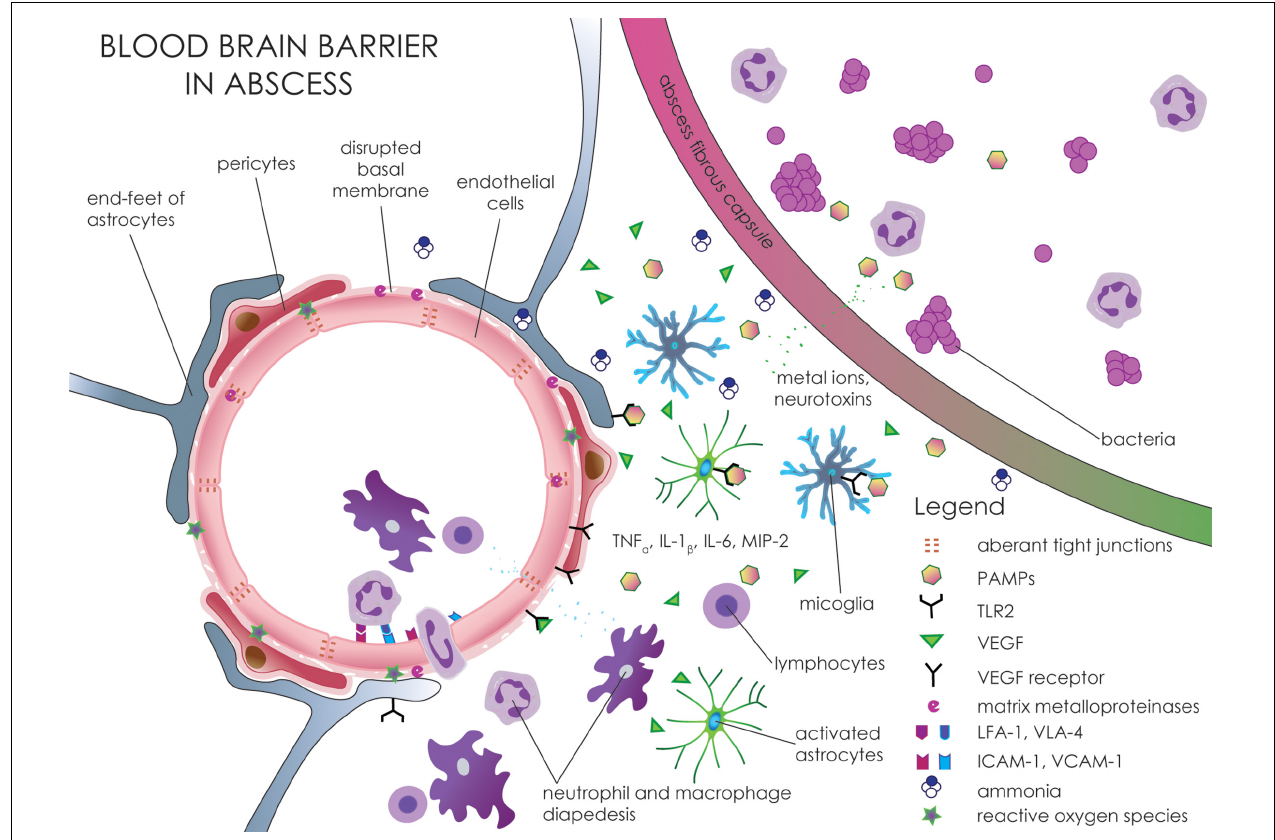
FIGURE 6 | Molecular and cellular changes in the blood-brain barrier around brain abscess. Bacteria and other microorganisms in brain abscess release PAMPs that are recognized by TLR2 on astrocytes and microglia. Activation of TLR2 receptors leads to increased expression of various cytokines and chemokines, including TNF- α , IL-1 β , IL-12, and MIP-2. These pro-inflammatory molecules increase the expression of adhesion molecules such as ICAM-1 and VCAM-1 that interact with integrins (LFA-1 and VLA-4) on immune cells and thus potentiate the transfer of leukocytes across the BBB. The pro-inflammatory molecules, as well as ROS, lead to increased expression and activation of matrix metalloproteinases resulting in disruption of TJ proteins. The formation of ROS is potentiated by metal ions, mainly potassium, zinc, and copper, that are released from the abscess. Moreover, decreased expression of TJ proteins such as claudin-5 and occludin is also potentiated by increased expression of VEGF from reactive